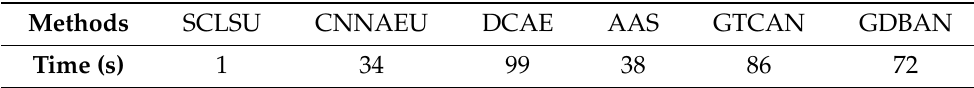
Table 3. Running time comparison.